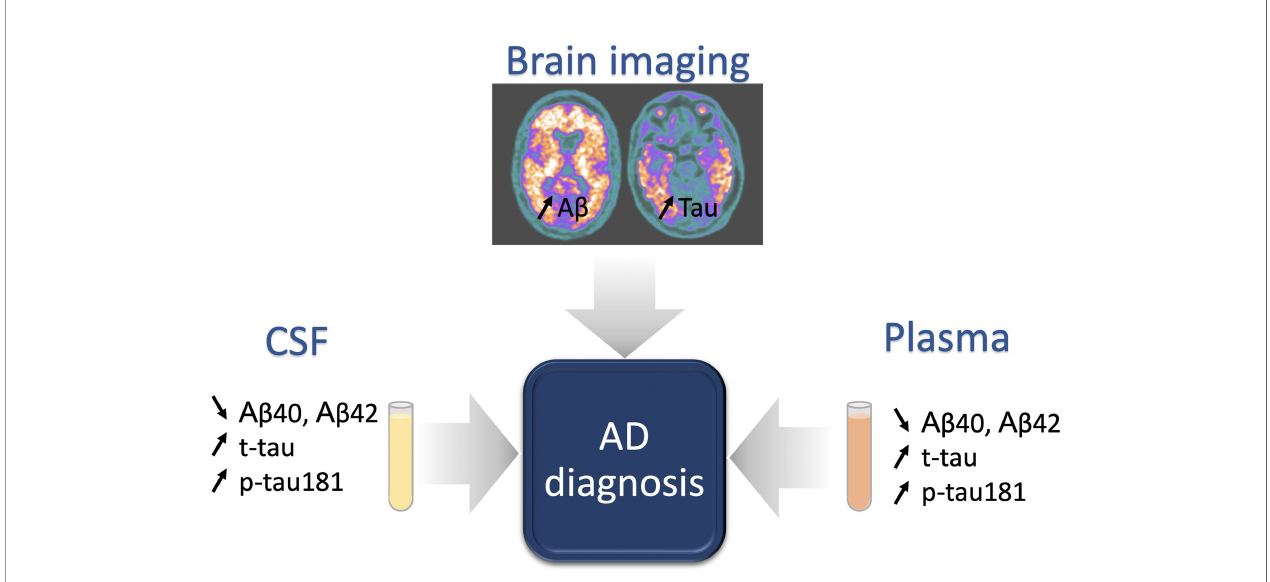
FIGURE 2 | Classical biomarkers for AD diagnosis. Brain imaging and fl uid biomarkers are under intense development for AD diagnosis. An increase of amyloid deposits and tauopathy are observed in the brain of AD patients with a well-de fi ned pattern, evolving during pathology progression. Tauopathy biomarkers, including classically the total tau (t-tau) and phosphorylated Tau on Threonine 181 (p-tau181), follow the same pro fi le of expression in fl uids (cerebrospinal fl uid (CSF) and plasma), with an increase of concentration during the pathology. At the opposite, low levels of amyloid peptides (A b 40 and A b 42) in the CSF or in the plasma re fl ect high amyloid deposition in the